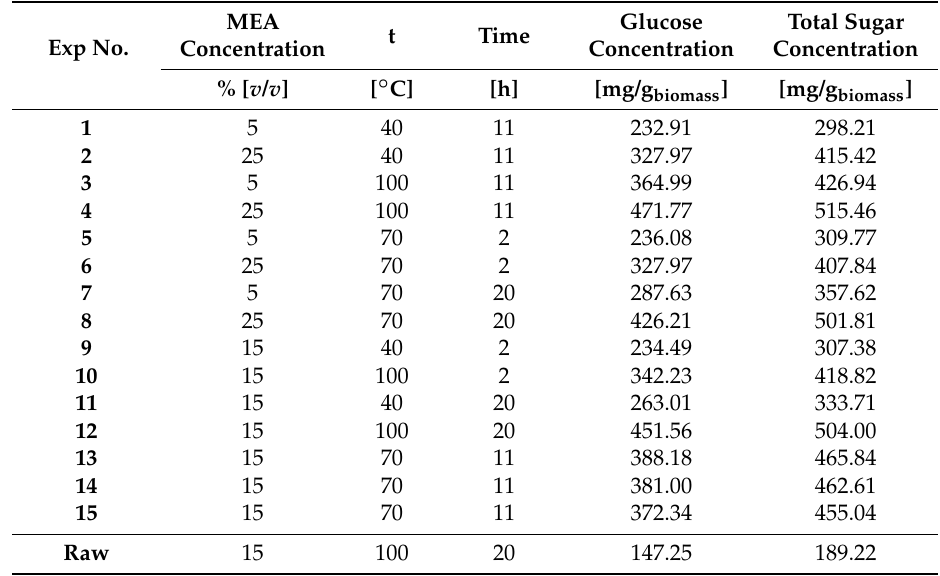
Table 5. Box-Behnken experimental design for two-step hydrolysis of EP and enzymatic hydrolysis of raw EP. MEA Time Exp No. Concentration